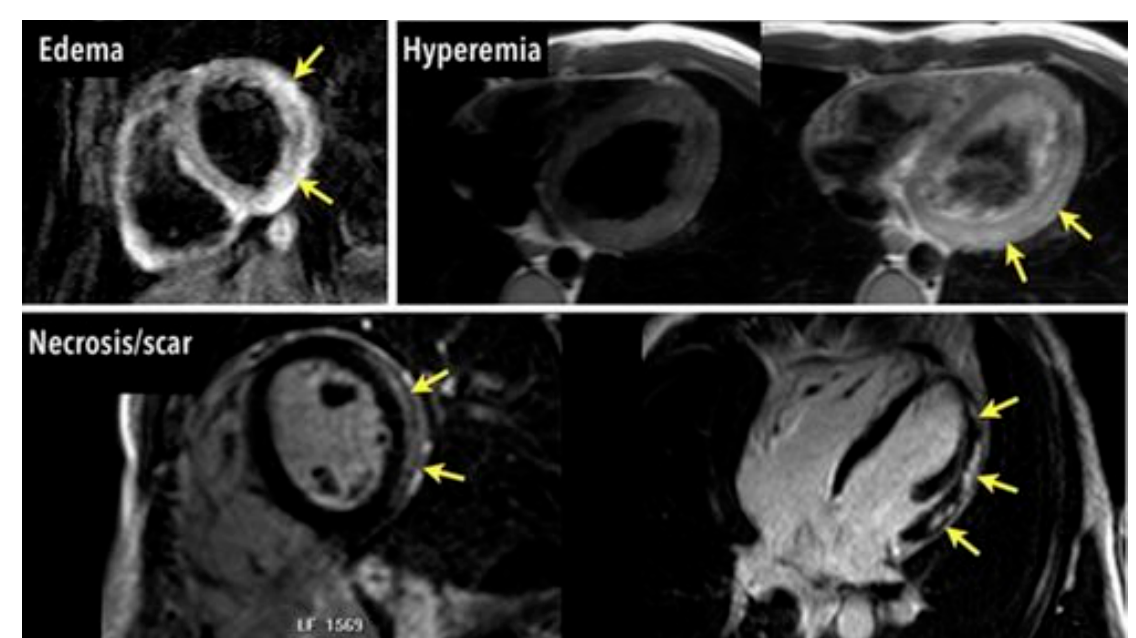
Figure 1. Myocarditis. Myocardial “Edema” identified using T2-weighted imaging. “Hyperemia” identified with early gadolinium enhancement. “Necrosis/scar” identified with late gadolinium enhancement. Yellow arrows are shown to indicate the respective re-gions of abnormal myocardial enhancement in myocarditis [45]